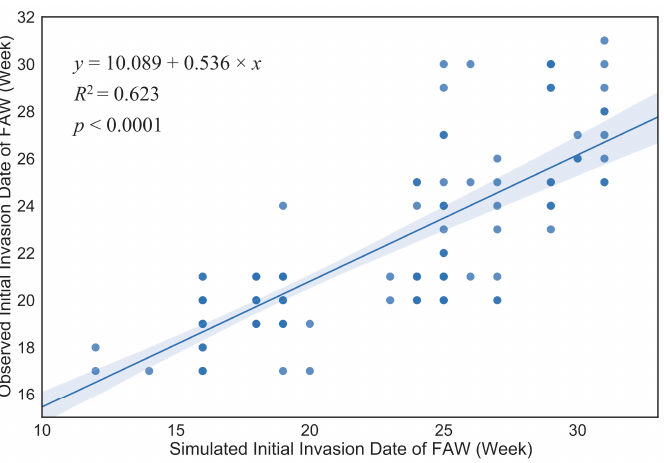
Figure 4. Linear regression of the observed initial invasion dates (week no.) and simu-